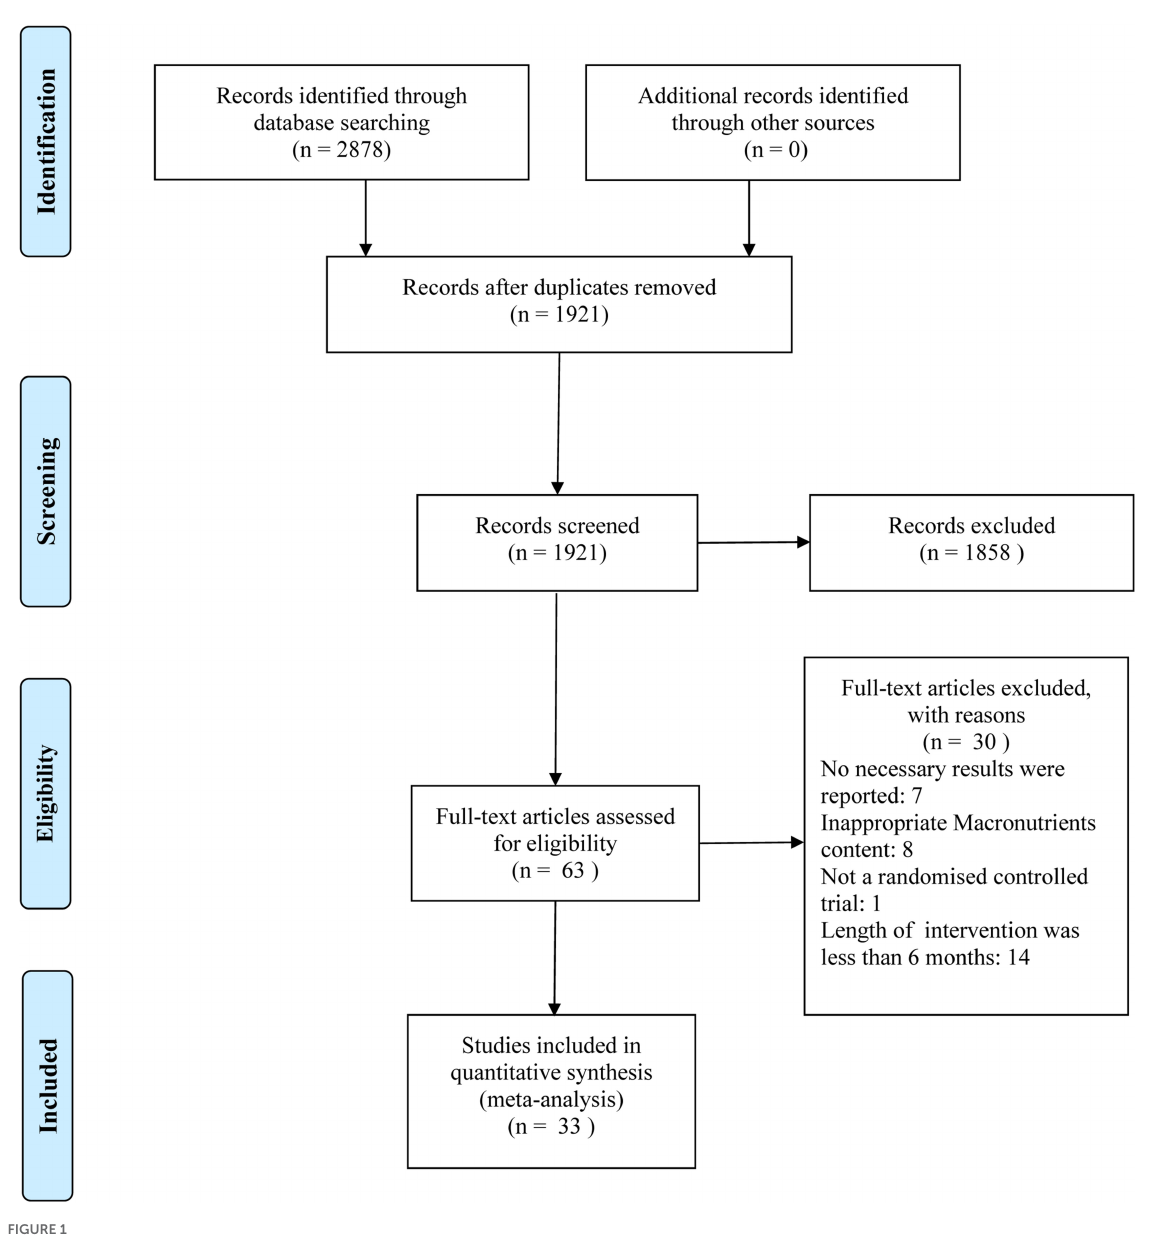
FIGURE1 Flow diagram of study selection and